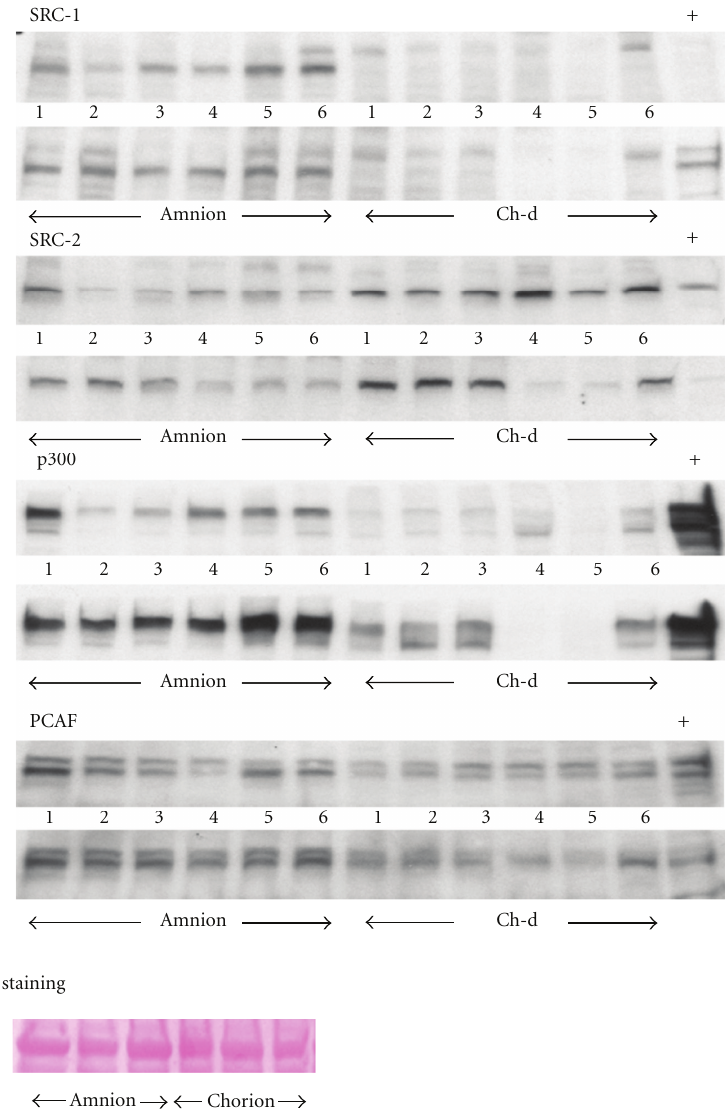
Figure 1: Representative Western blots of amnion and chorion-decidua (Ch-d) of six di ff erent tissues from non-labor patients undergoing elective cesarean section (C/S) and six labor patients after spontaneous vaginal delivery. Blots were probed with antisera specific to SRC-1, SRC-2, p300, and PCAF. Nuclear extracts from K562 cells (Santa Cruz) were used as a positive control for these proteins (+). Lanes marked 1–3 represent C/S tissues and 4–6 represent labor tissues. Typical Ponceau S staining, used as loading control, is shown in the lower